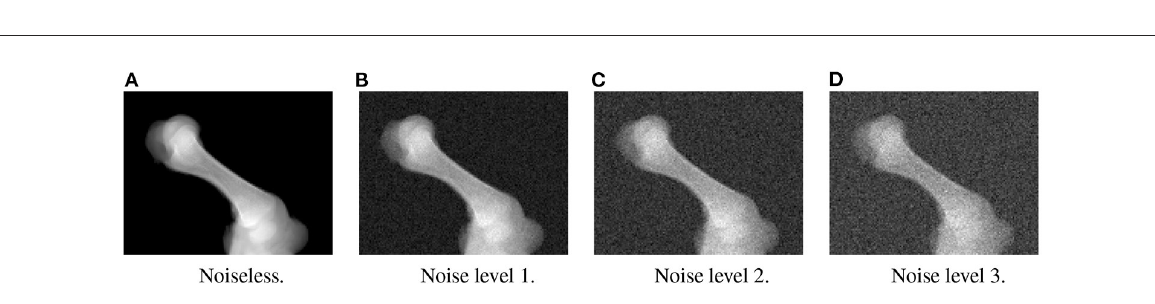
FIGURE9 Four sample projections from each of the simulated datasets with noiseless (A) , low (B) , moderate (C) , and high noise level (D)